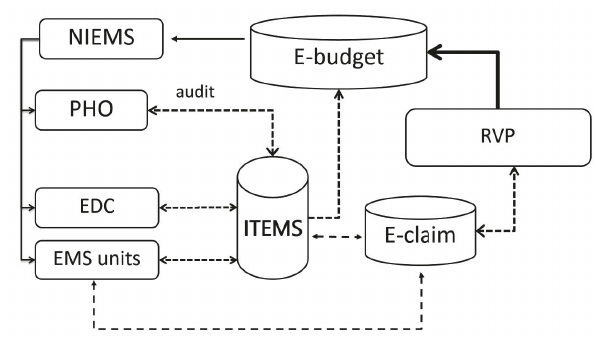
Figure 2: Data and financial flows under NIEMS and RVP col- laboration on E-claim payment system. Note: EDC: emergency dispatch center; PHO: provincial health office; E-budget: electronic budgeting dataset under NIEMS (National Institute of Emergency Medicine); E-claim: electronic claim dataset under RVP (Road Accident Victims Protection Company Limited); dash line: data flows; solid line: financial